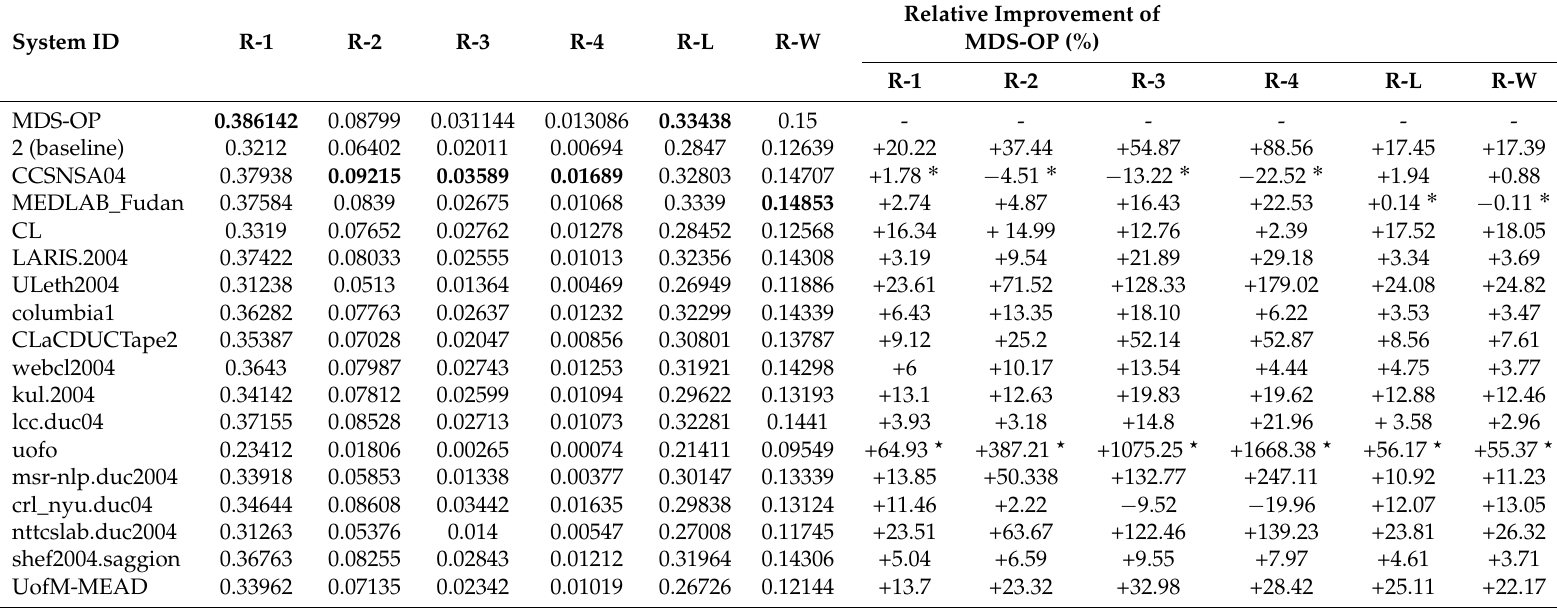
Table 4. F-measure scores of ROUGE-1, ROUGE-2, and ROUGE-3, ROUGE-4, ROUGE-L, and ROUGE-W-1.2 metrics of MDS-OP, the baseline, and the participating systems at DUC 2004 (Task 2). The highest values are written in bold. The highest and the lowest improvements (%) of MDS-OP are indicated by ‹ and ˚ ,